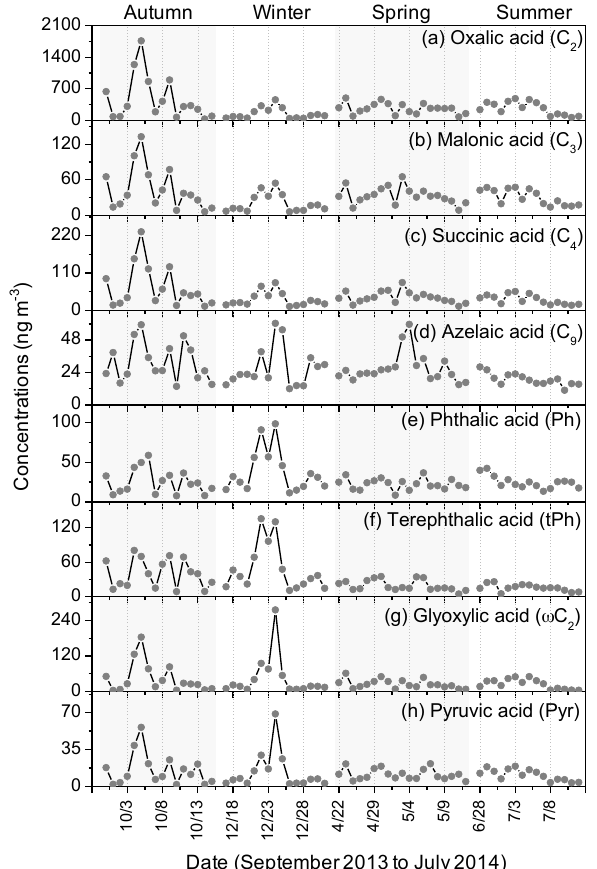
Figure 3. Daily variations in the concentrations of selected organic acids in the PM 2 . 5 aerosols in